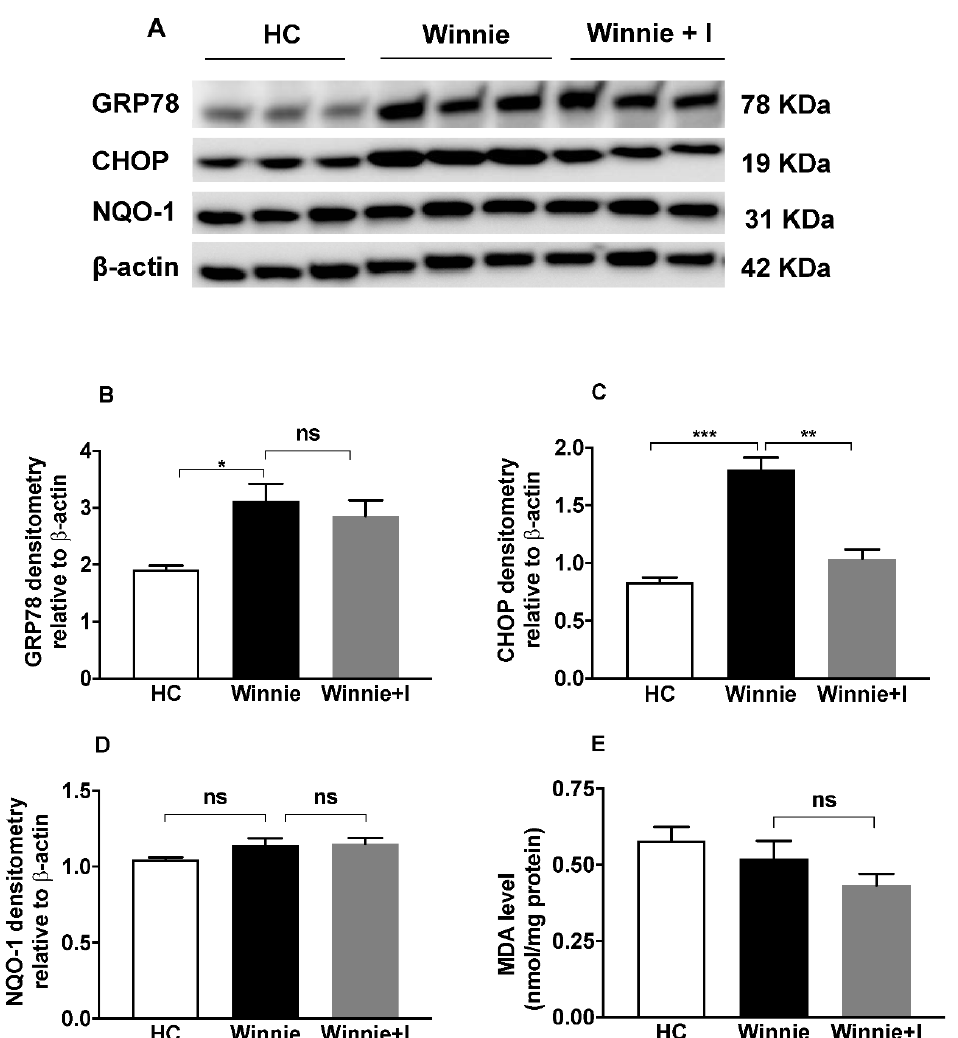
Figure 5. Effect of idebenone on endoplasmic reticulum stress (ER stress) and oxidative stress in spontaneous chronic colitis in Winnie mice. ( A ) protein levels of GRP78, CHOP and NQO-1 were analyzed using western blotting of tissue samples from the distal colon (DC), ( B – D ) densitometry of GRP78, CHOP and NQO-1 expression. Band densities were normalized to β -actin. ( E ) malondialdehyde (MDA) levels in distal colon. Data represents mean ± SEM ( n = 3 / group). Statistical significance was determined using One-way ANOVA followed by Tukey’s post-test, where * p < 0.05, ** p < 0.01 and *** p < 0.001 and ns: